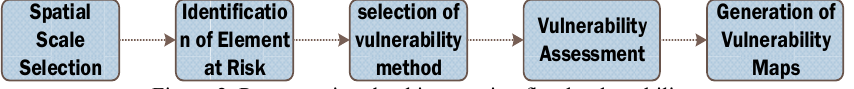
Figure 2. Processes involved in mapping flood vulnerability